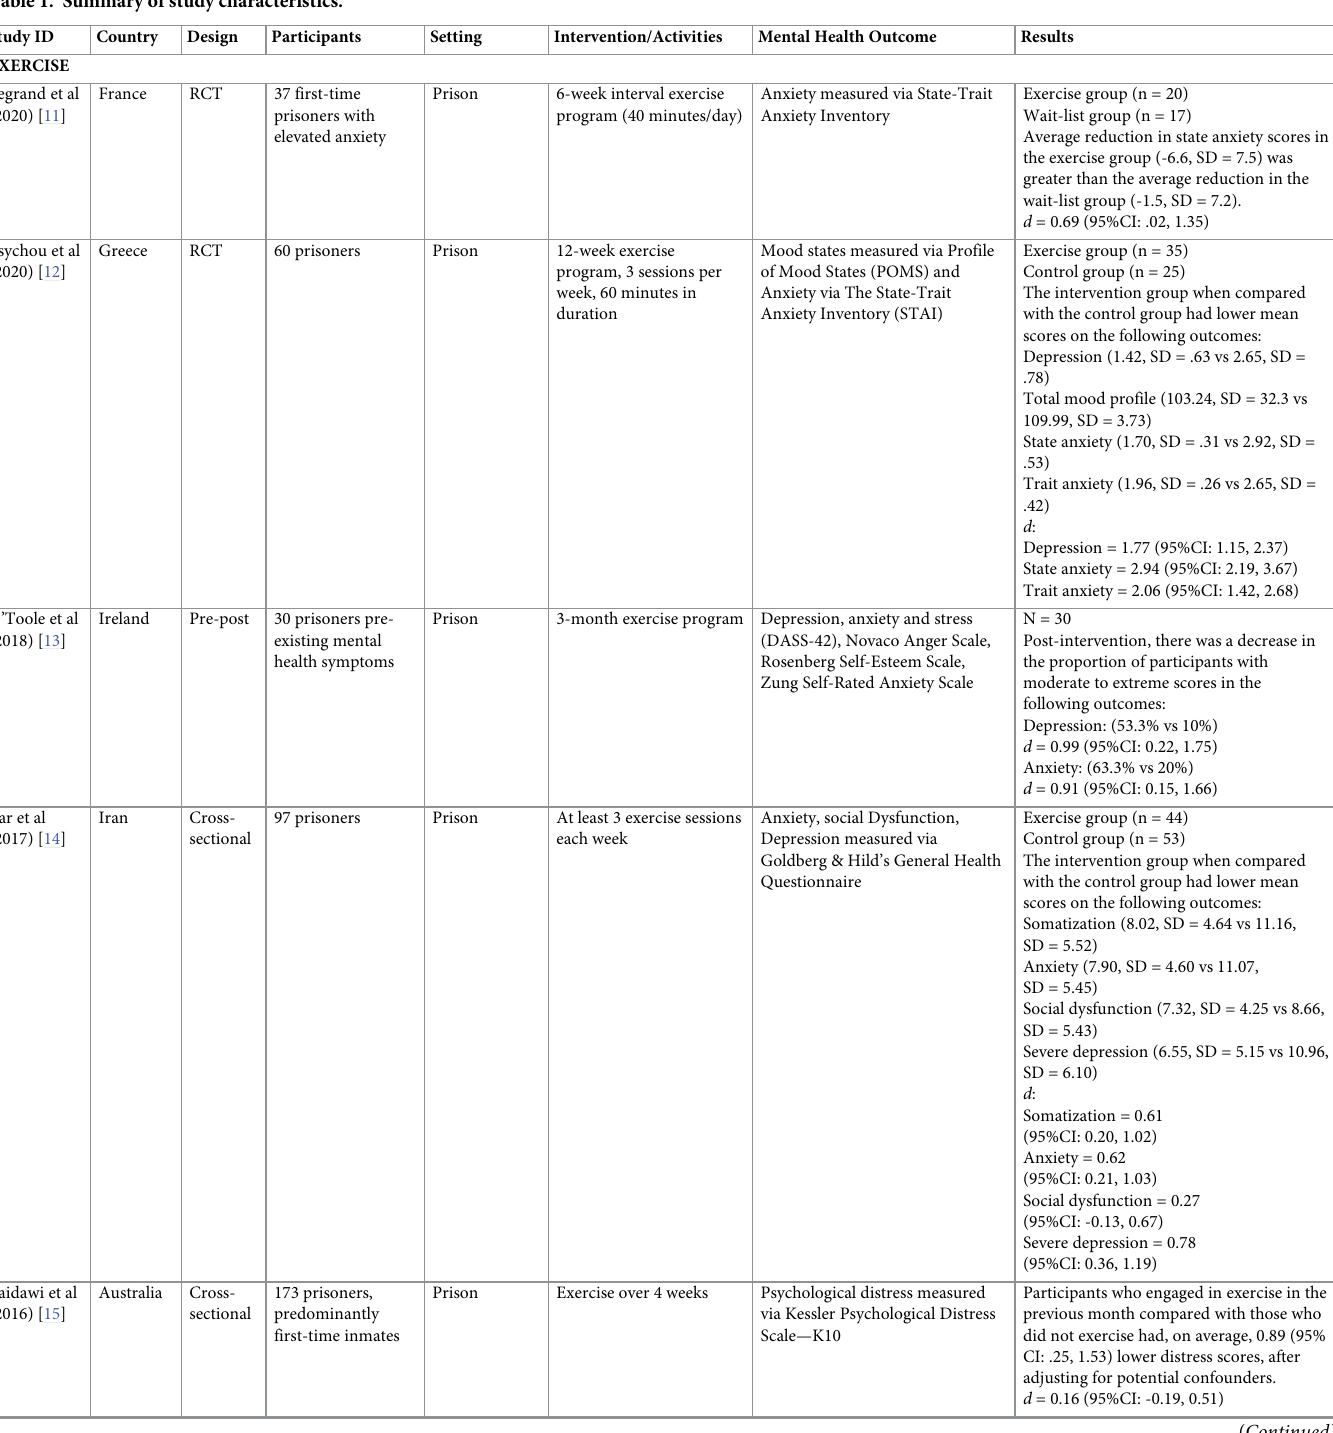
Table 1. Summary of study